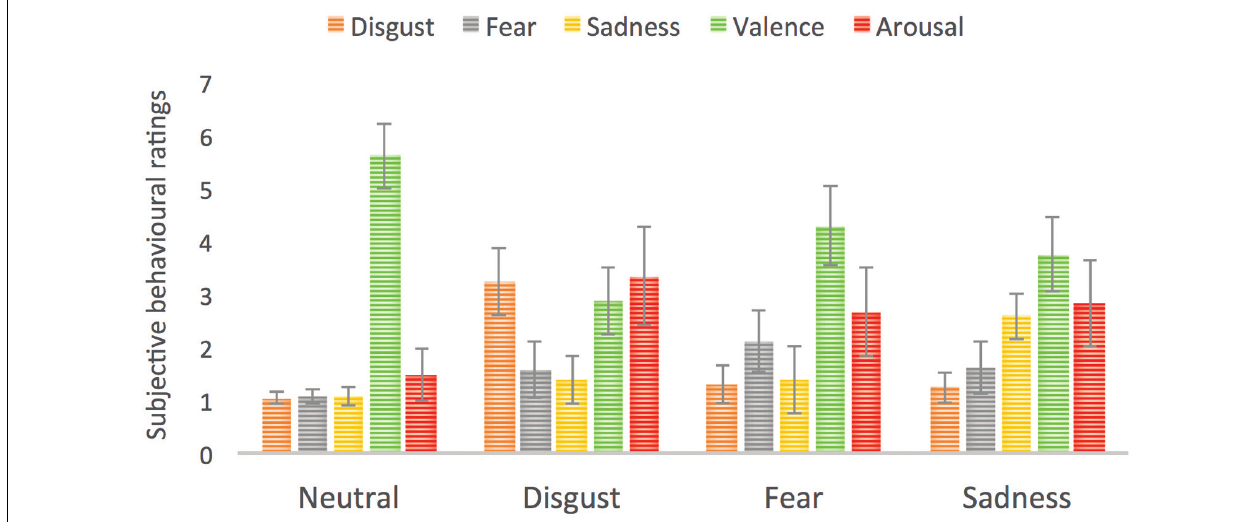
FIGURE 4 | Subjective ratings for four types of stimuli used in the study. Error bars represent standard deviation. For the purpose of enhancing visibility of differences we used a scale going from 0 to 7.